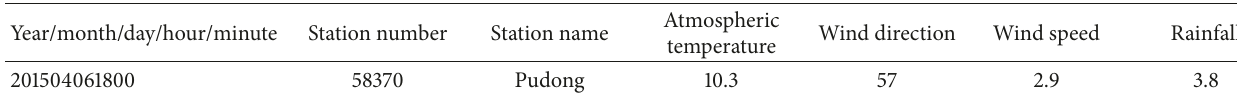
Table 4: Meteorological data.